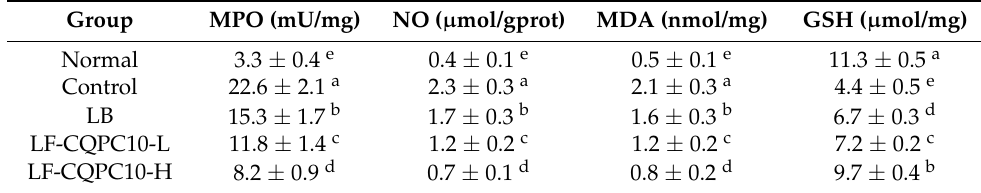
levels. Table 6. MPO, NO, MDA, and GSH levels in the small-intestine tissue of mice with activated Table 6. MPO, NO, MDA, and GSH levels in the small ‐ intestine tissue of mice with activated carbon-induced constipation. carbon ‐ induced constipation.